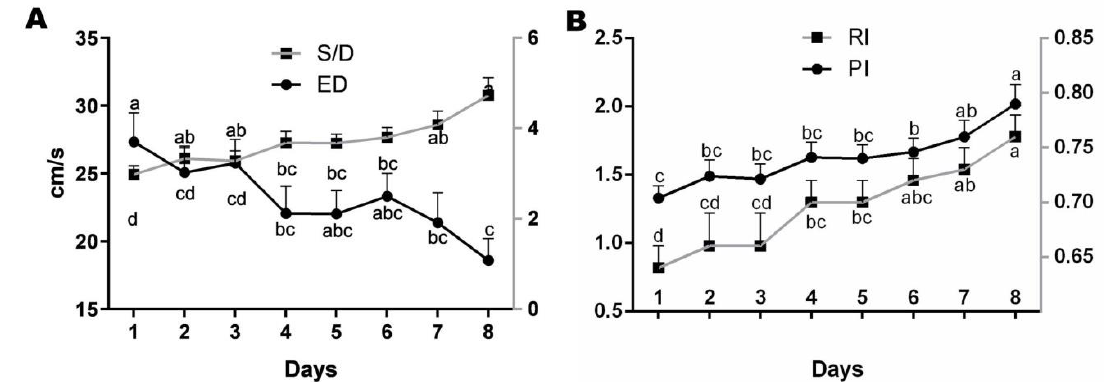
Figure 2. Endometrial vascularization score in cross-section Color Flow Doppler. ( A ) score 1 (minimum), ( B ) score 2 (intermediary) and ( C ) score 3 (maximum). (Below) Endometrial vascularization score (1–3) throughout the experimental period (1–8 days). a–e values with different letters differ significantly with